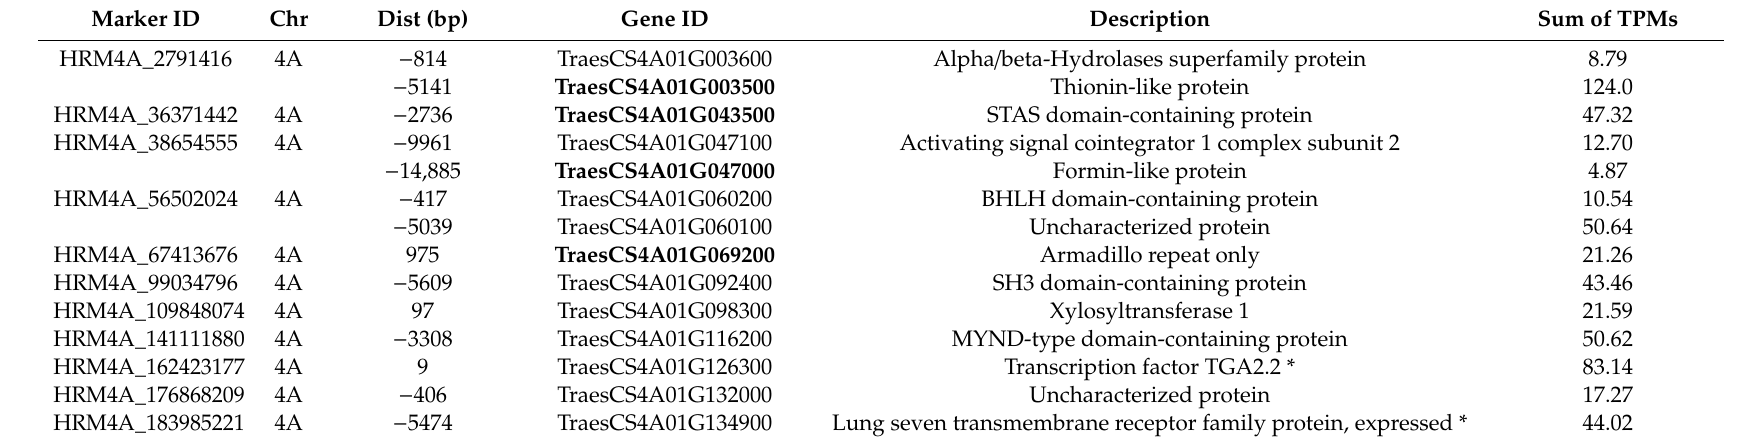
Table 2. Wheat chromosome 4A ISBP markers linked to genes which alter their expression in response to water stress treatments. DE genes are shown in bold. The positive and negative values in “ Dist ” column indicate if the corresponding gene is downstream or upstream of the